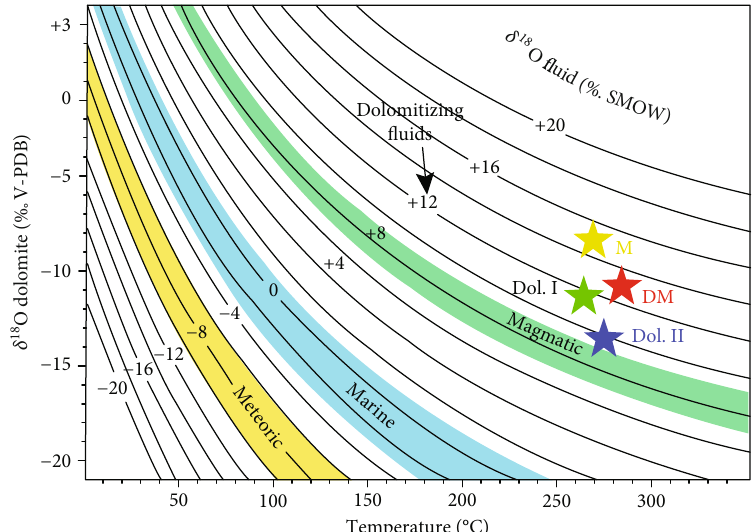
Figure 13: The average precipitation temperature versus oxygen isotopic composition of the analyzed carbonate phases. The star shows their mean values of the observed diagenetic phases. (a) The δ 18 O of the fl uid in equilibrium with inferred values of dolomite (Dol. I, Dol. II), marble (M), and dolomitic marble (DM) was calculated using the fractionation equation of Land [69]. Meteoric water [76]. Marine water [77]. Magmatic water